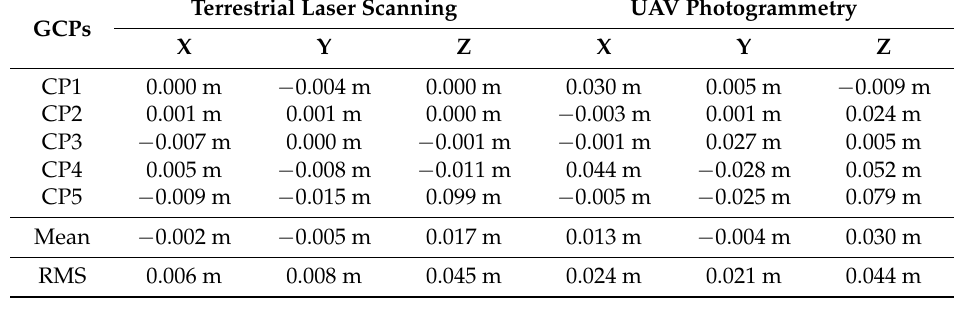
Table 1. Comparison of coordinate errors of the point data obtained via terrestrial laser scanning and UAV photogrammetry based on the five ground control points.